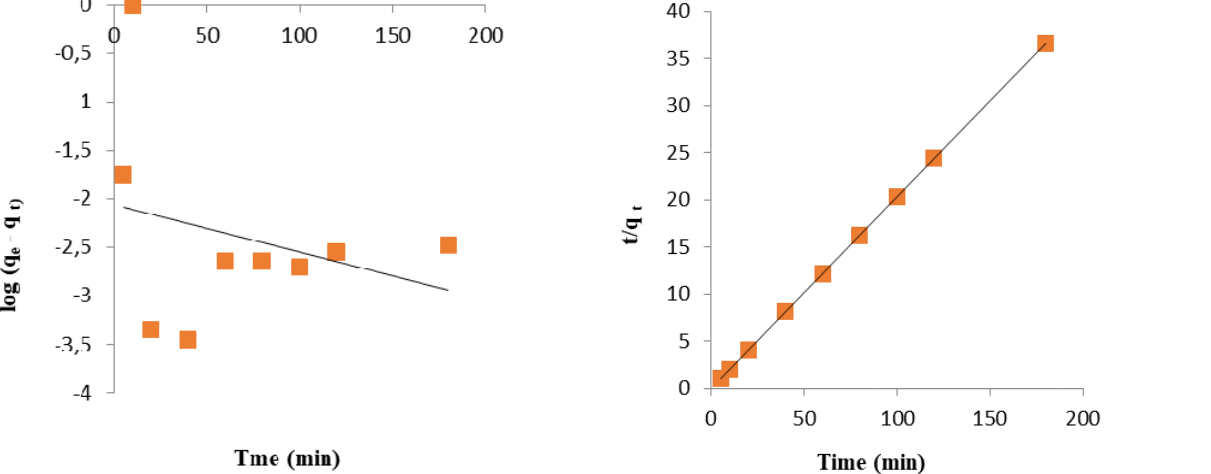
Fig. 8. Pseudo- second-order kinetic modeling of Cd 2+ adsorption onto SEZ at initial concentration 10 mg/L (25 ± 0.2 °C)